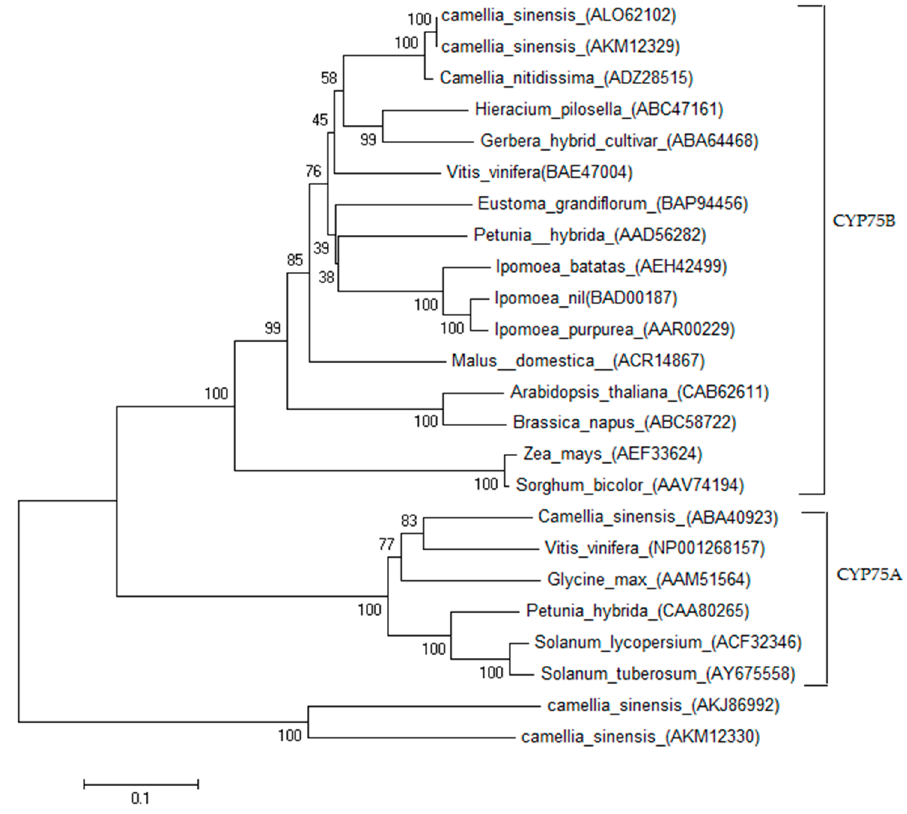
Figure 3. Phylogenetic analysis of CsF3’H protein and the proteins of F3’H and F3’5’H from other species. The phylogenetic tree was constructed from the ClustalW alignment using the neighbour joining method by the MEGA 6.0 program. Branches were labelled with the protein names and GenBank accession numbers. The scale bar represents 0.1 substitutions per site, and the numbers next to the nodes were bootstrap values from 1000 replicates.